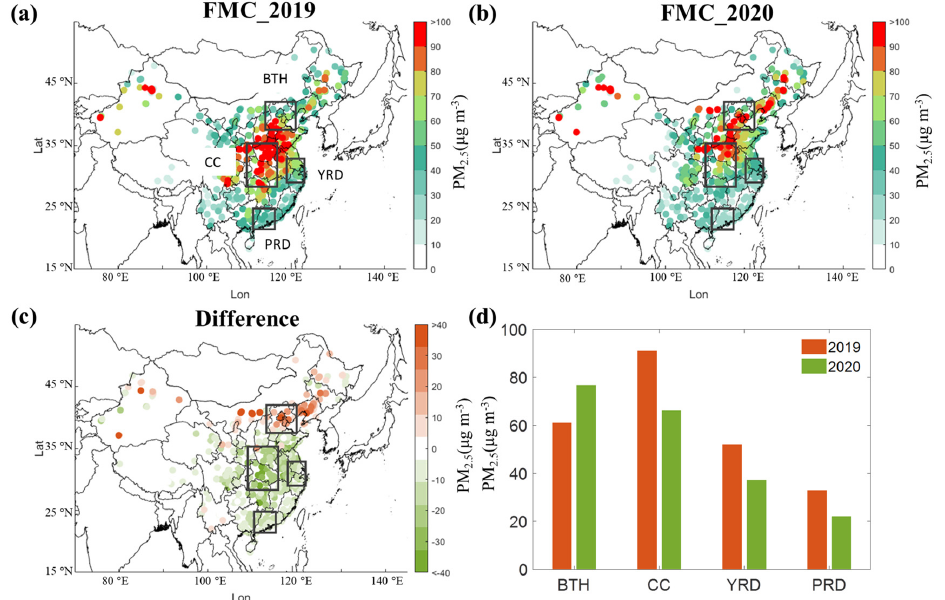
Figure 2. Distributions of monthly average PM 2.5 mass concentration (µg m − 3 ) in China. ( a ) FMC_2019. ( b ) FMC_2020. ( c ) Difference of PM 2.5 mass concentration between FMC_2019 and FMC_2020. ( d ) The histogram of PM 2.5 mass concentration in the BTH, the CC, the YRD, and the PRD.